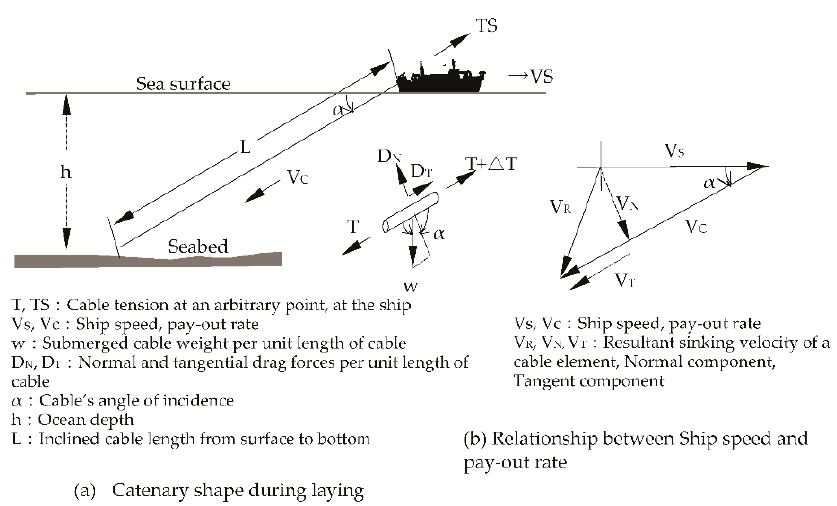
Figure 5. Forces acting on a cable in normal laying. ( a ) Catenary shape during laying; ( b ) relationship between ship speed and pay-out rate.